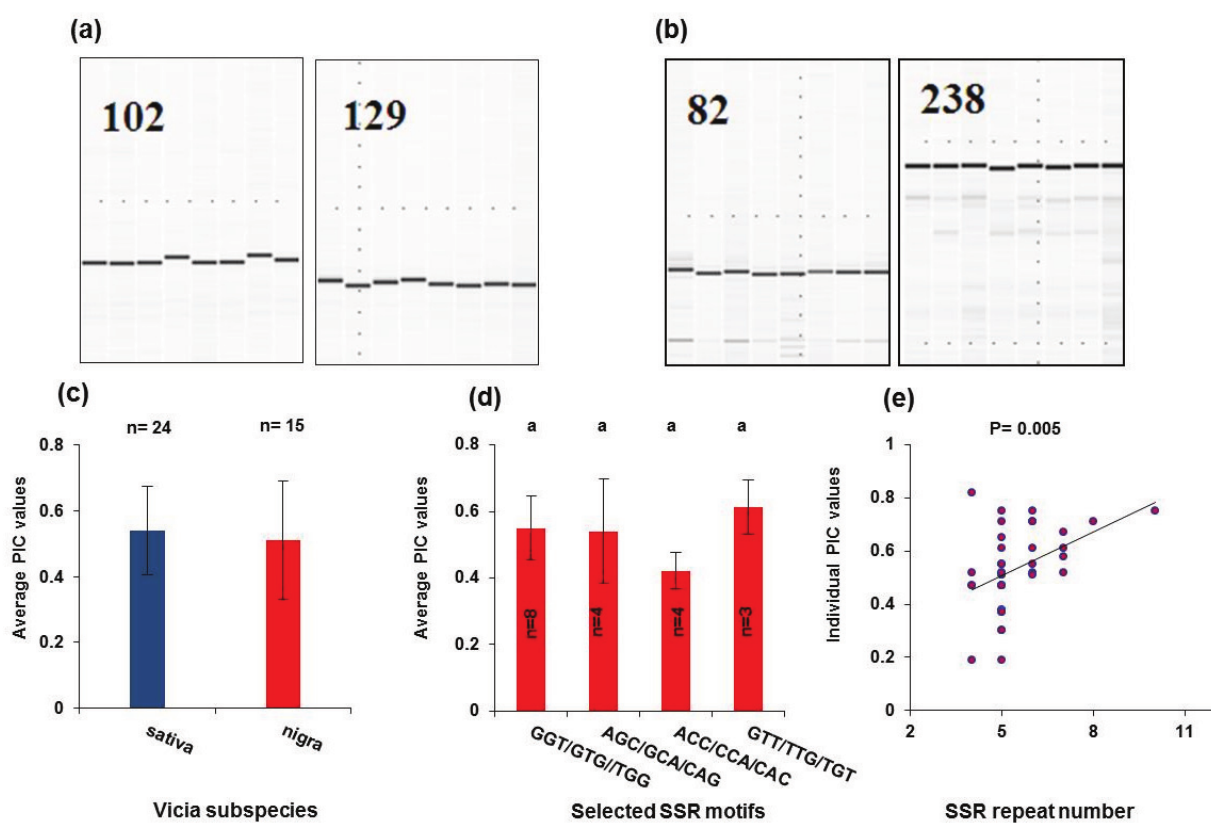
Figure 4. Empirical validations of the polymorphism of SSRs in Vicia sativa nigra and sativa using eight randomly-selected accessions. ( a ) Gel images showing the PCR products from the eight accessions for the representative SSR loci in Vicia sativa sativa ; ( b ) those images for Vicia sativa nigra ; ( c ) graph showing the overall average polymorphism index content (PIC) values; ( d ) average PICs by the SSR motif; ( e ) correlation between PIC and SSR repeat number. The numbers in gel images in ( a , b ) represent the names of the SSR loci; ( c , d ) n represents the number of SSR loci used to estimate PIC, and error bars indicate standard deviations; ( d ) different letters represent one(s) that is (are) significantly different from the others (determined by comparison of all pairs using the Tukey-Kramer HSD test); ( e ) p -values are determined by simple linear regression